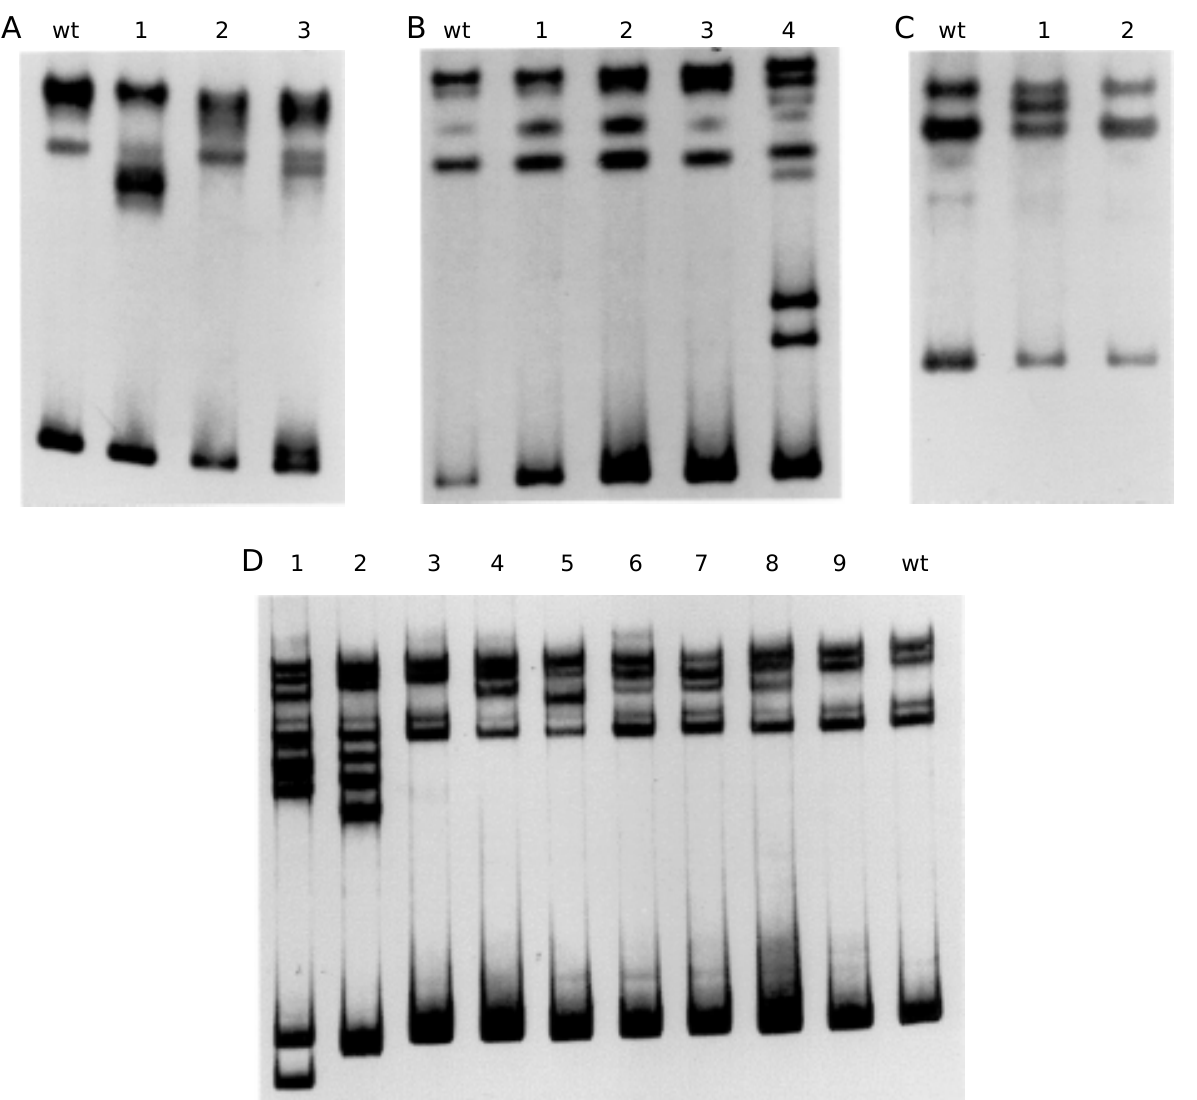
Figure 1 - p53 Gene alterations detected by non-isotopic SSCP in standard silver-stained polyacrylamide gels. A , PCR products of exon 5 amplified from an HPV-positive cervical carcinoma with a single nucleotide substitution (G fi A) (lane 1), an HPV-negative cervical carcinoma with a normal exon 5 sequence (lane 2), a gastric carcinoma with a single nucleotide substitution (G fi A) (lane 3). B , PCR products of exon 6 from HPV-positive cervical carcinomas with single nucleotide substitutions (A fi G) (lanes 1, 2), an HPV-negative penile carcinoma with a single substitution (A fi G) (lane 3), a gastric carcinoma with a 3 nucleotide deletion in codon 181 (lane 4). C , PCR products of exon 7 from an HPV-negative penile carcinoma with two nucleotide substitutions (C fi A and C fi T) (lane 1), an HPV-negative cervical carcinoma with a normal exon 7 sequence (lane 2). D , PCR products of exons 8 and 9 from head and neck tumors with normal (lanes 3, 9) and altered nucleotide sequences (lanes 1, 2, 4, 5 6, 7, and 8). wt: Corresponds to the normal sequences amplified from the cervical carcinoma cell line HeLa (A,B,C) and from a head and neck tumor